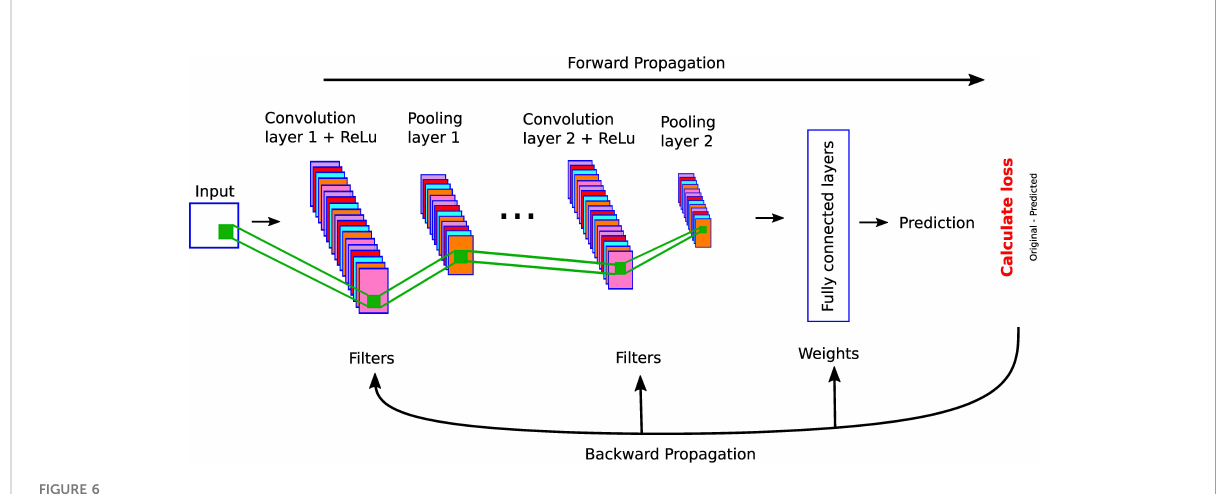
FIGURE 6 A simple CNN architecture with convolutional, pooling, and fully connected